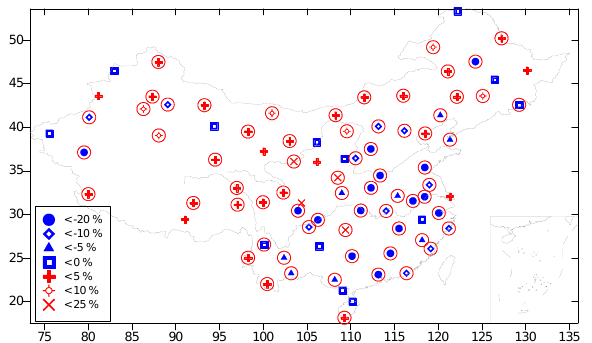
Fig. 5. The same as Fig. 1, but for good visibility (visibility greater than 20.0km) analysis at 87 stations. The significant decline in Figure 5. The same as Figure 1, but for good visibility (visibility greater than 20.0 km) good visibility is evident in eastern part of China, where most sta- analysis at 87 stations. The significant decline in good visibility is evident in eastern part tions showed more than a 20% decline per decade in the occurrence of China where most stations showed more than 20% decline per decade in the of good visibility. The increase in good visibility in Western China occurrence of good visibility. The increase of good visibility in western China is is attributed to a remarkable decrease in dust storms attributed to a remarkable decrease of dust storms there.